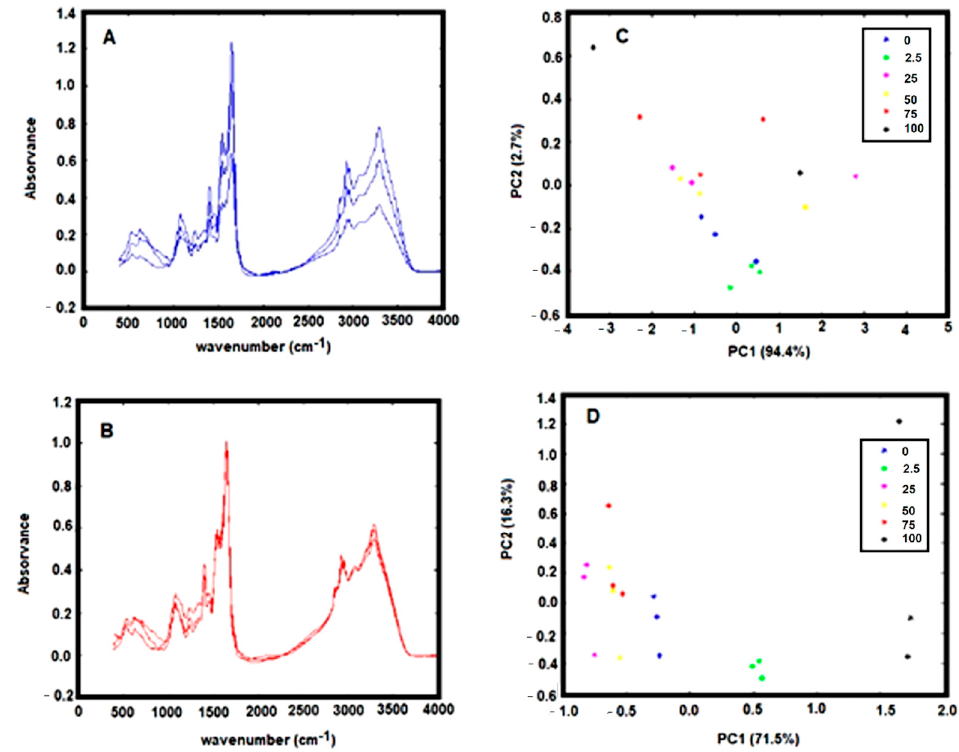
Figure 1. ( A ) Triplicate FTIR spectra, of dehydrated H. pylori with an OD 600 nm of 4.0, baseline-corrected by off-set. ( B ) Same replicate spectra as indicated in A with a multiplicative scatter correction (MSC); ( C ) PCA score-plot relative to FTIR spectra, of H. pylori incubated with different concentrations of the drug model, baseline-corrected by off-set. ( D ) Same data as presented in C with MSC correction. Legend of symbols: Blue—0 mg/L; Green—2.5 mg/L; Magenta—25 mg/L; Yellow—50 mg/L; Red—75 mg/L; and Black—100 mg/L.